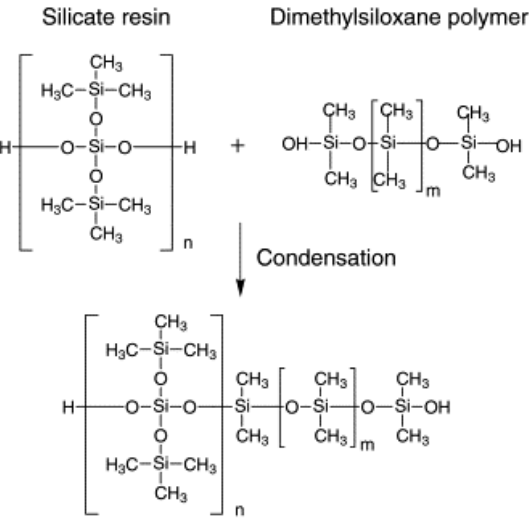
Figure 3. The chemistry of silicone pressure-sensitive adhesives (PSAs). Reprinted from [26], © 1999 with permission from